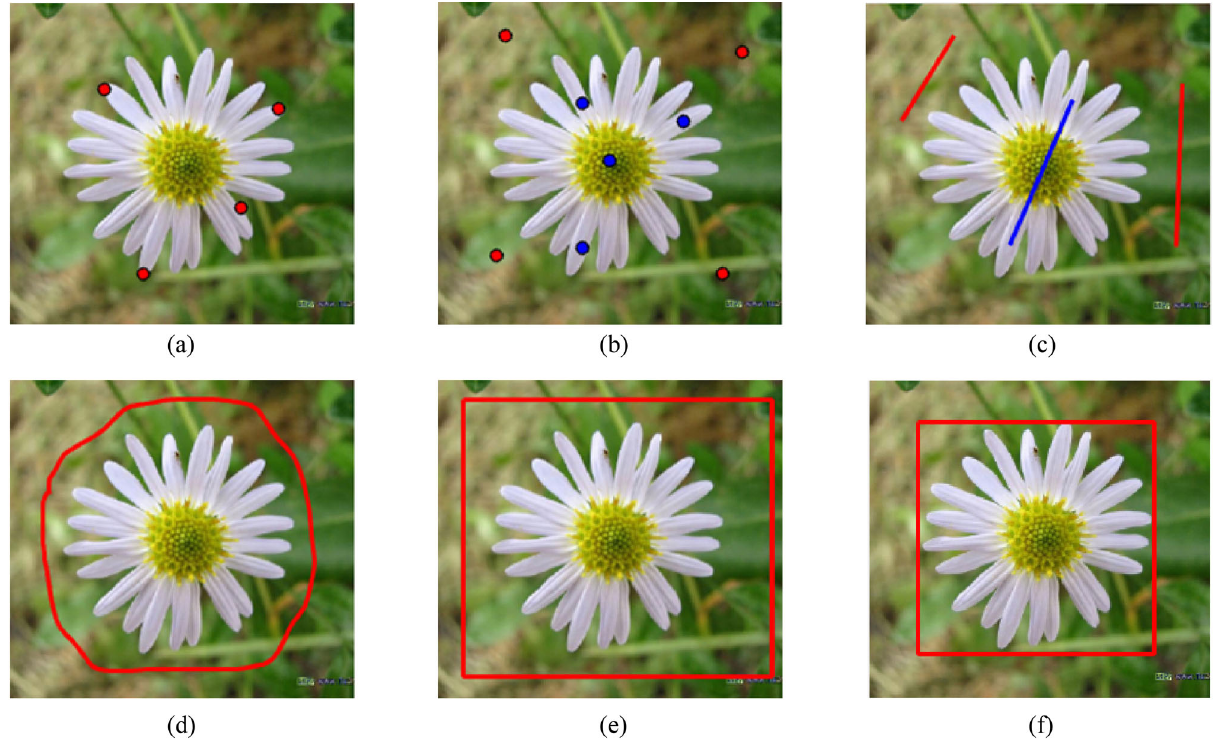
Fig. 2 Different modalities of user input in IIS. (a) Boundary seeds. (b) Region seeds, FG, and BG points. (c) Region seeds, FG, and BG strokes/scribbles. (d) ROI, drawn. (e) ROI, loose BB. (f) ROI, tight